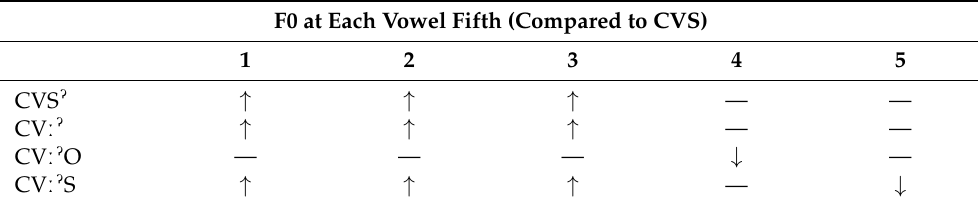
Table 5. F0 differences between stød-bearing words and CVS words per fifth of the vowel. ↑ indicates that the word type with stød has significantly higher F0 that CVS words during that time interval. ↓ indicates that the word type with stød has significantly lower F0 than CVS words during that time interval. Dashes indicate no significant